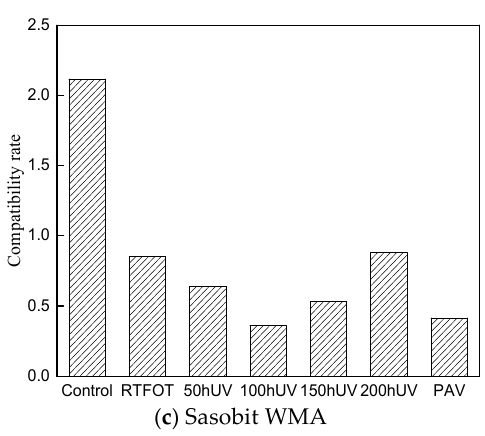
Figure 8. Influence of aging on compatibility rate of aged asphalt.